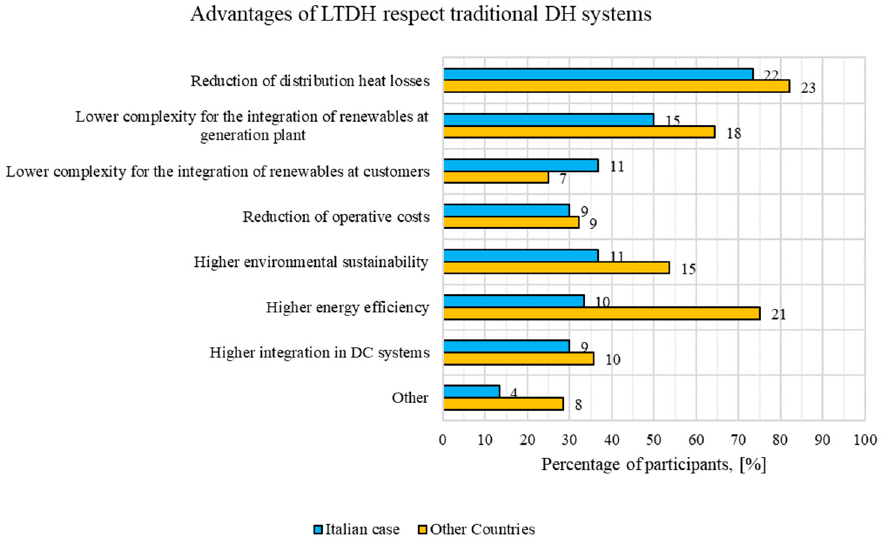
Figure 21. Advantages of LTDH with respect to traditional DH systems.